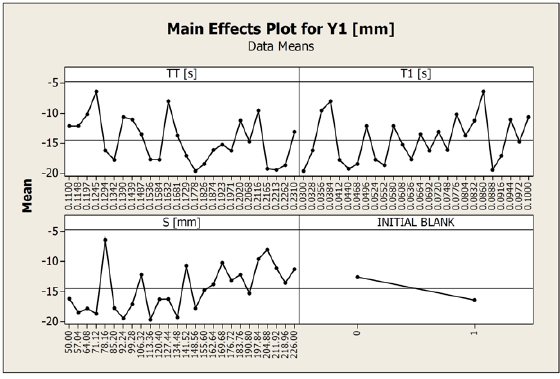
Figure 21. MEP for X2 output.